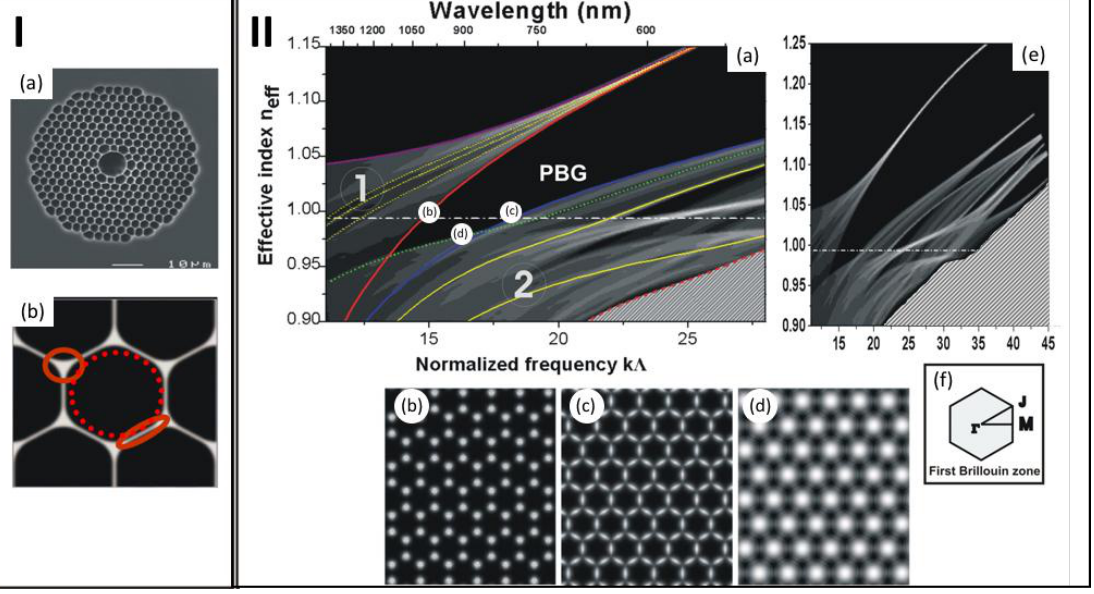
Figure 9. ( I ) HCPCF designed for 1064 nm guidance: ( a ) SEM of the fiber and ( b ) zoom in of its cladding structure. The red lines indicate the interstitial apex, the silica strut, and the air hole regions. ( II ) Numerical modeling: ( a ) Propagation diagram for the HCPCF cladding lattice; near field of ( b ) the interstitial apex mode, ( c ) the silica strut mode, and ( d ) the air hole mode, ( e ) Zoom out of ( a ), ( f ) Brillouin zone symmetry point